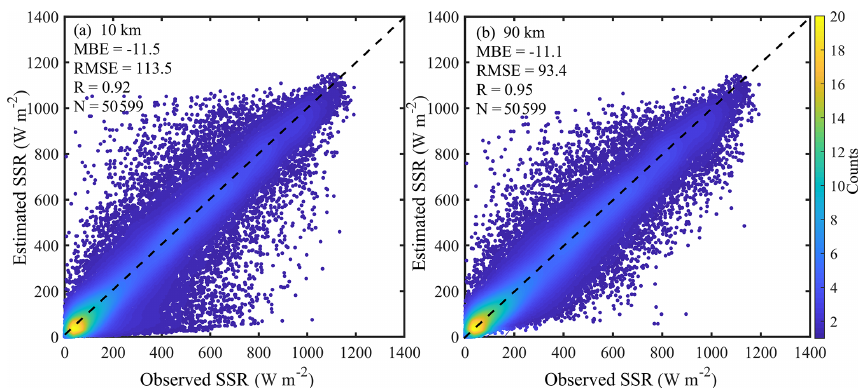
Figure 2. Comparisons of our estimated instantaneous SSR at spatial resolutions of (a) 10km and (b) 90km with observed SSR for 42 BSRN stations.